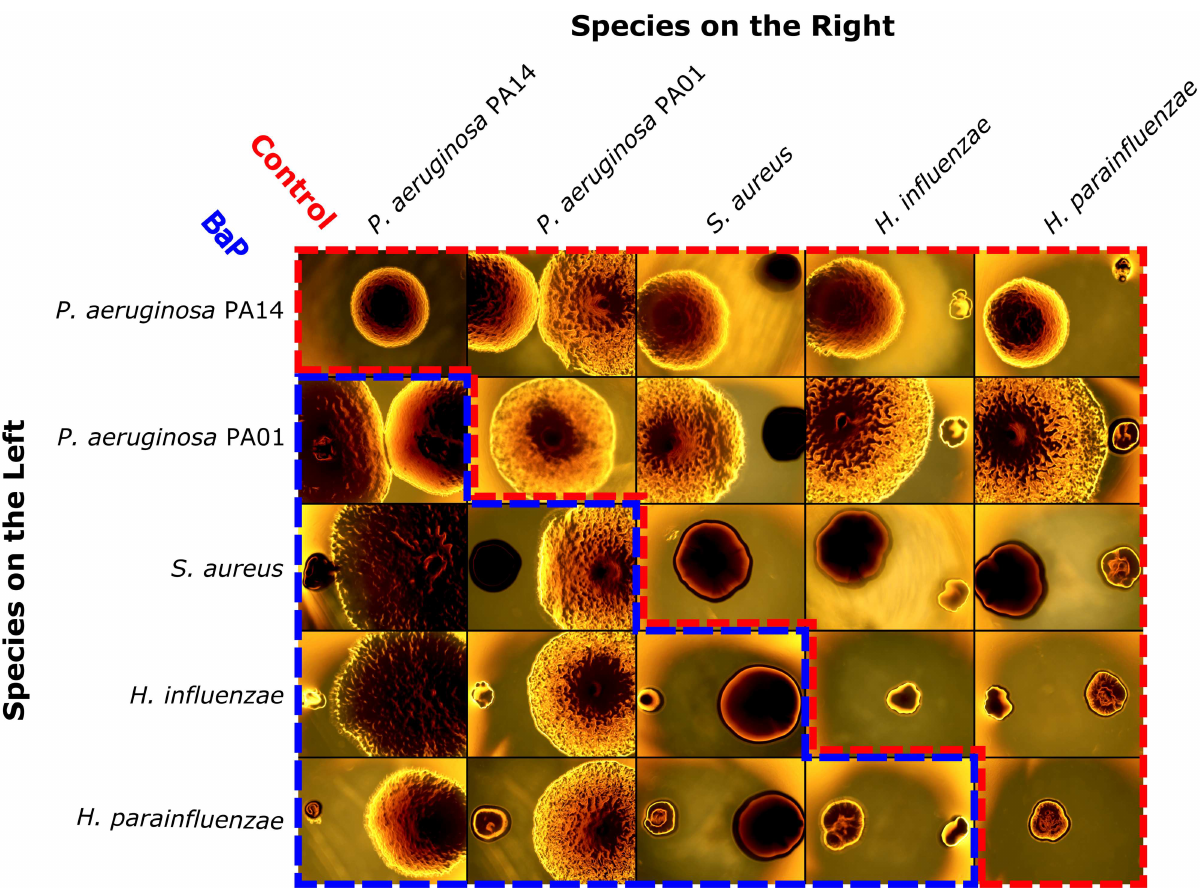
Fig 2. Representative images of bacterial colonies. After being stamped and grown for 24 hours, we imagedall the experimental conditions(six replicateseach of five species grown aloneand in pairs, in control and BaP conditions). Here we show representative images of the five speciesgrown alone in control media (alongthe diagonal),the pairwisecombinations in control media (upper triangularportion outlinedby red, dashedline), and pairwisecombinations in BaP media (lowertriangularportion outlined by blue, dashedline). The row indicatesthe species grown on the left and the column indicatesthe species grown on the right. Interactions were determinedby comparing colony area after growth alone to colony area after growth in the presenceof another species.